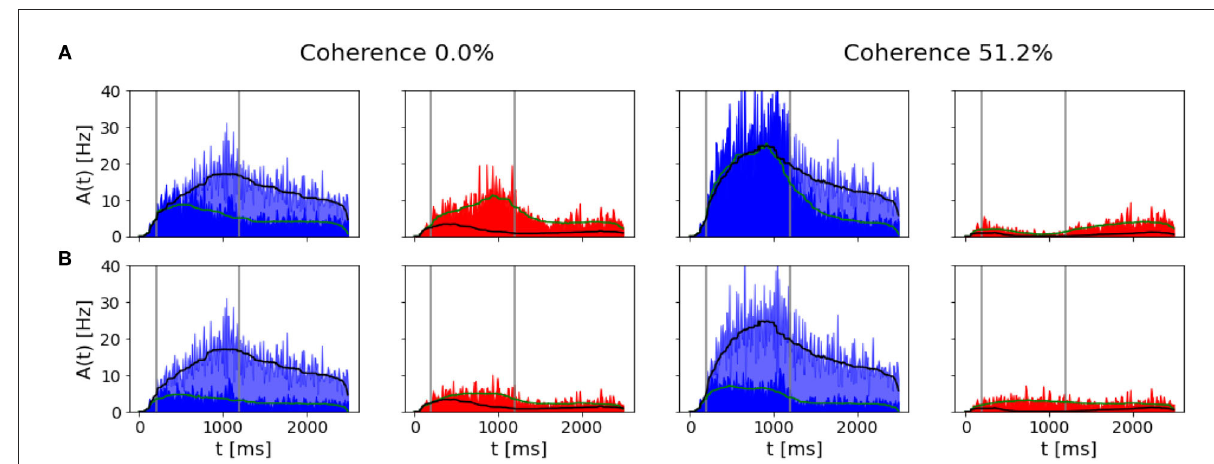
FIGURE5 Effects of strong recurrent connection and NMDA slow reverberation: (A) Simulation output for decreased recurrent weights. (B) Simulation output without NMDA slow dynamics. We reported in blue population B activity in the altered simulations, light blue the standard simulation output. For population A we reported in red the activity in altered simulation and light red the standard